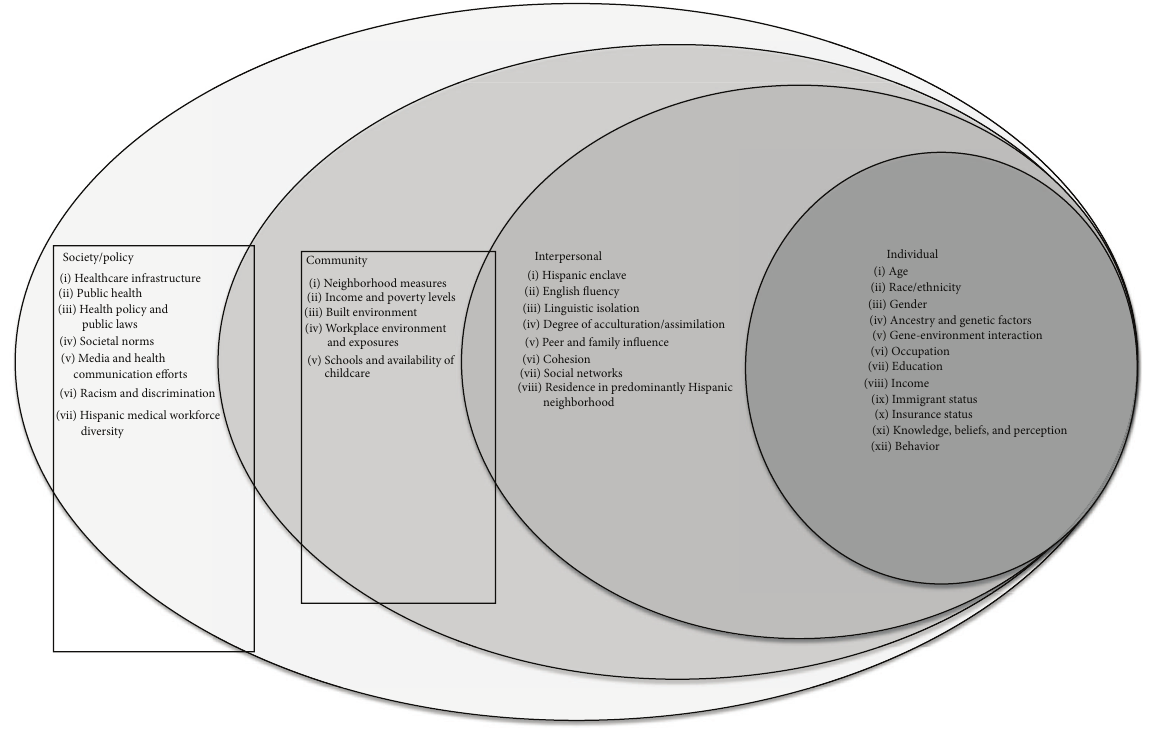
Figure 1: Social ecological model